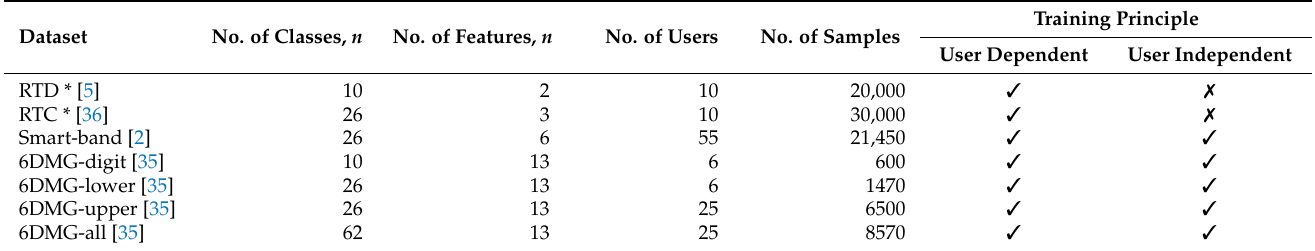
Table 1. Summary of the datasets used in this